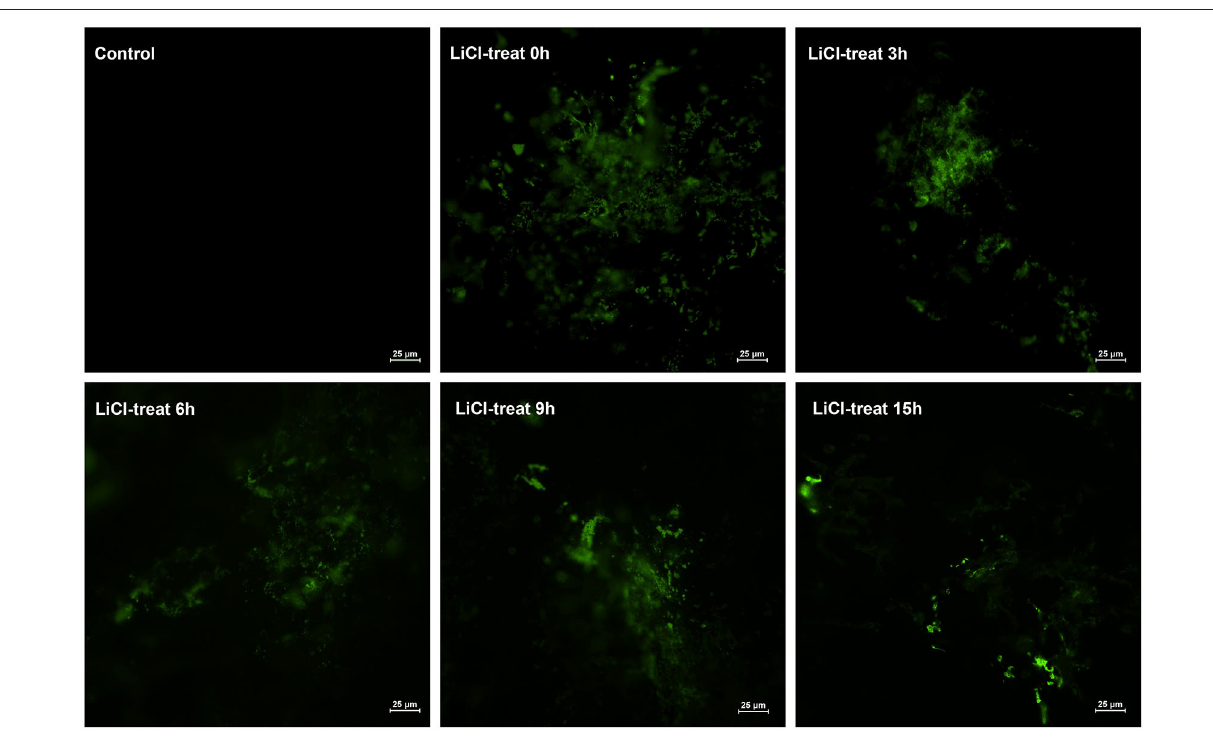
Frontiers in Microbiology |